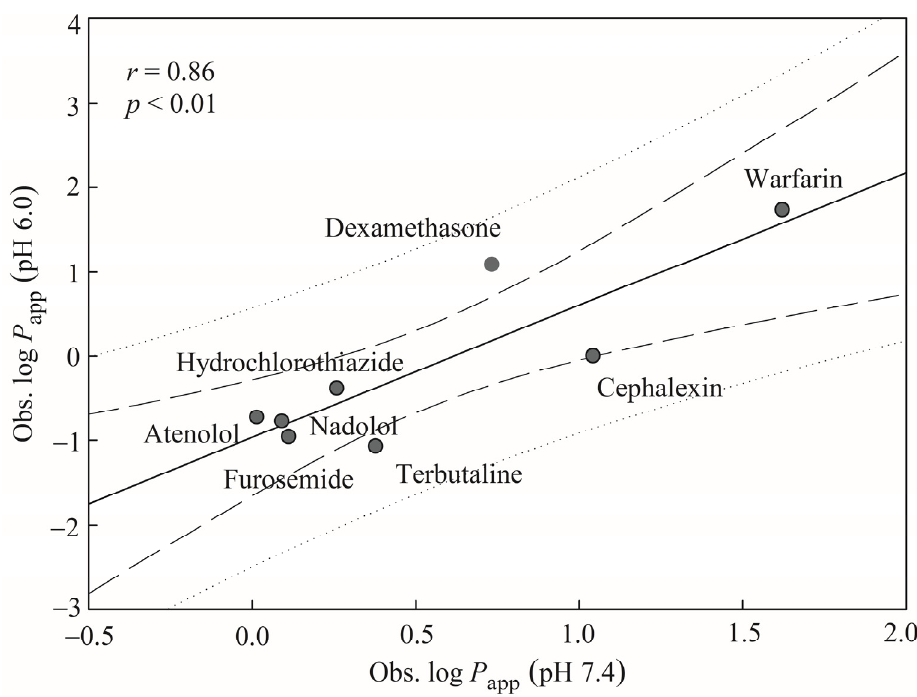
Figure 6. Observed log P app at pH 7.4 versus observed log P app at pH 6.0 for the common drugs in the mock test. The solid, dashed, and dotted lines represent the mock test regression of the observed data, 95% confidence interval for the mock test regression, and 95% confidence interval for the observation, respectively.